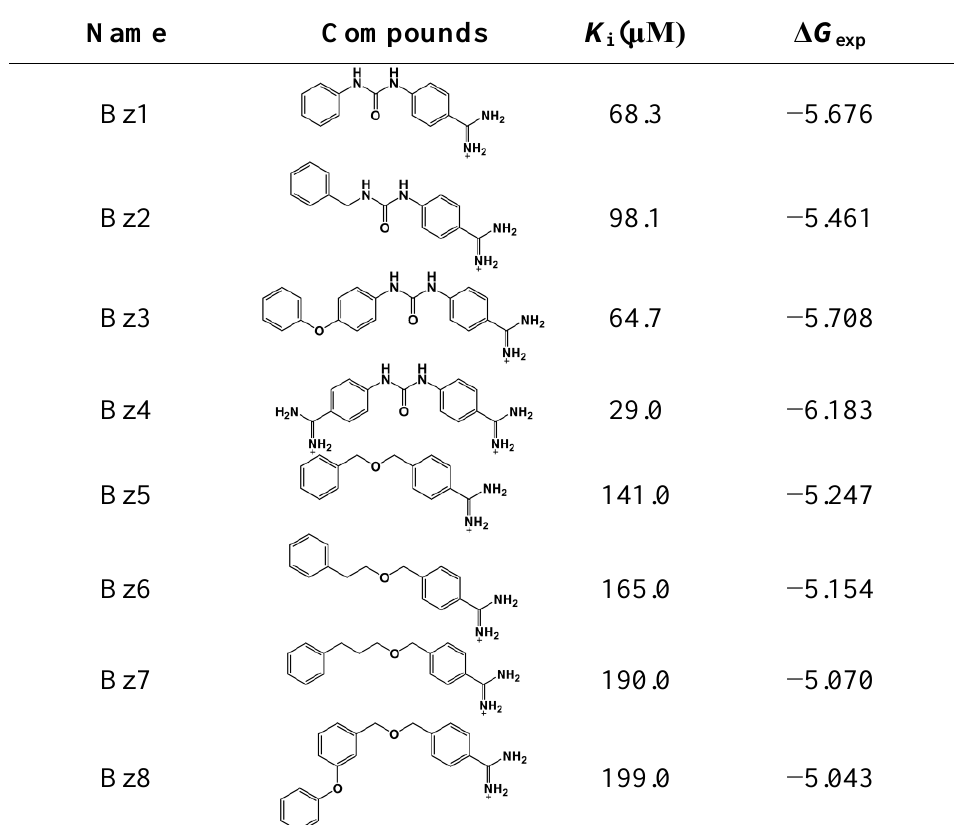
is the apparent inhibitory constant [14]. i